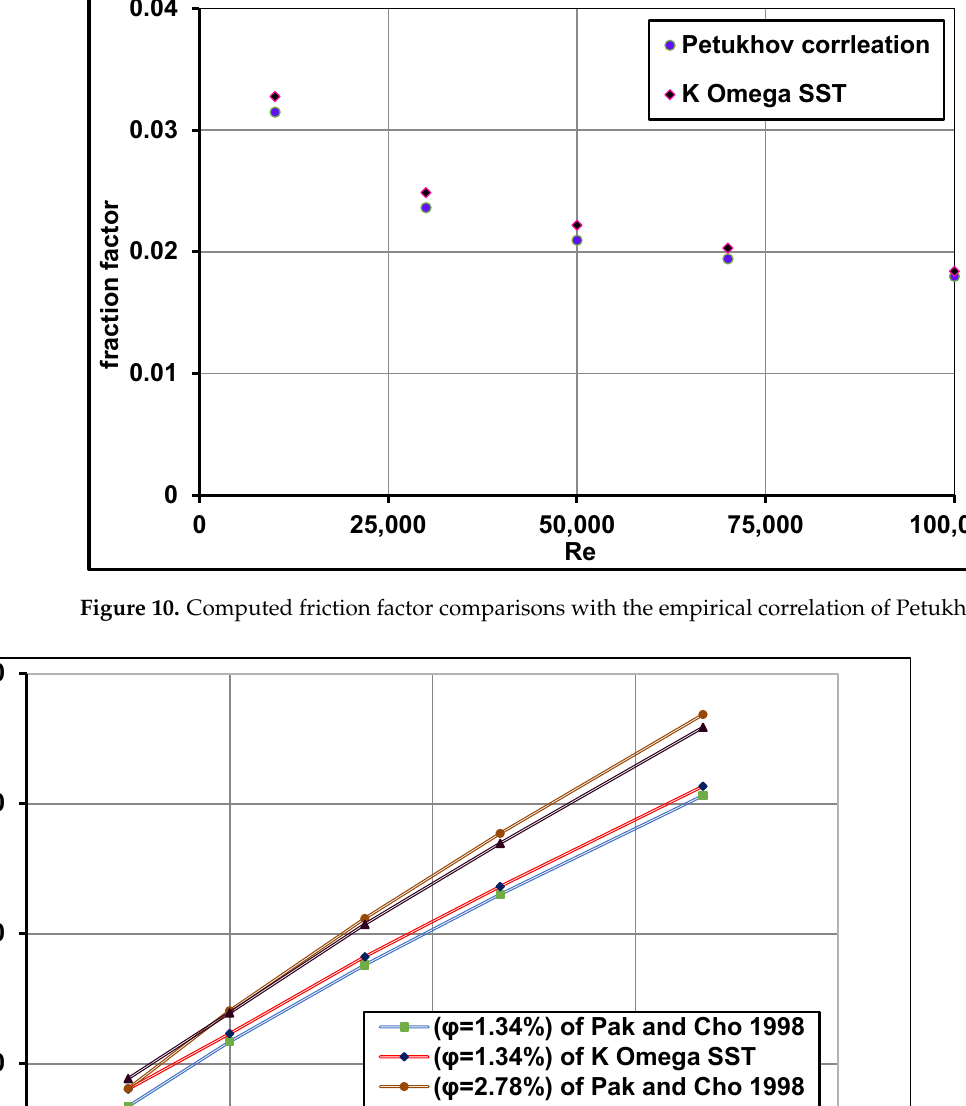
Figure 9. Computed thermal efficiency compassions against measurements of Dudley et al., [45]. The computed friction factor was also validated in the model with the empirical 𝑓𝑓